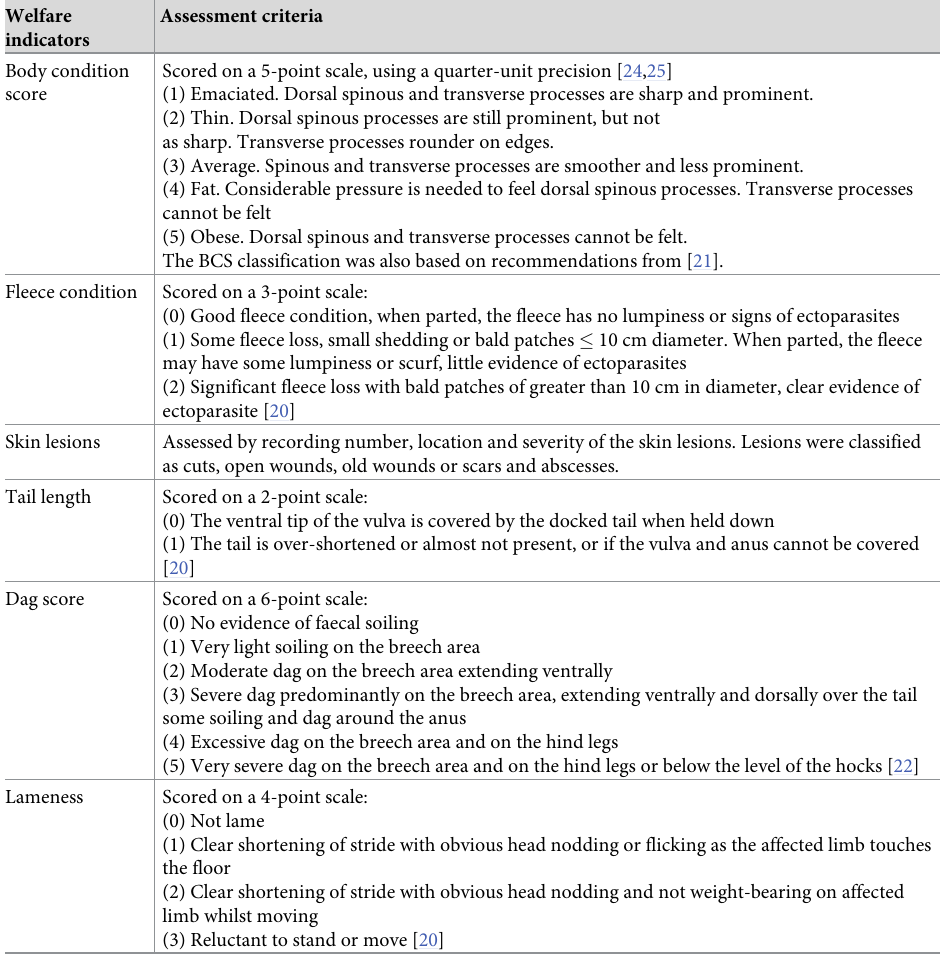
Table 1. Animal-based welfare indicators used to assess ewe